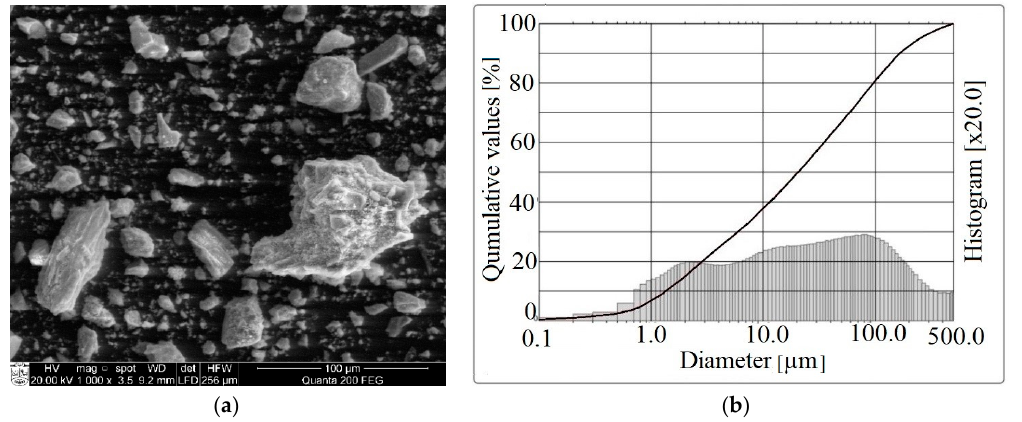
Figure 5. The SEM analysis ( a ) and granulometric composition ( b ) of biomass bottom ash.